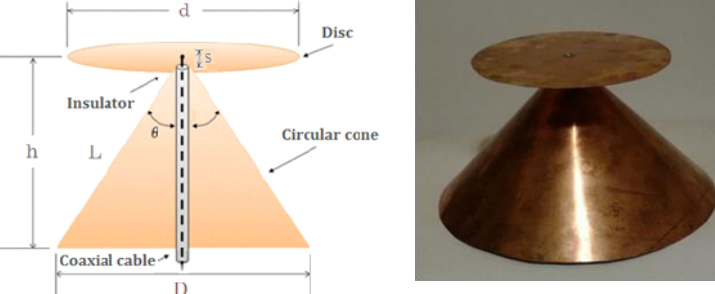
Figure 1. The main parts of the discone antenna: i) the disc, ii) the circular cone iii) the insulator (left) and the antenna prototype from copper foil, with an inner cone angle 90 o , height 12 cm and low-cut frequency 750 MHz (right)